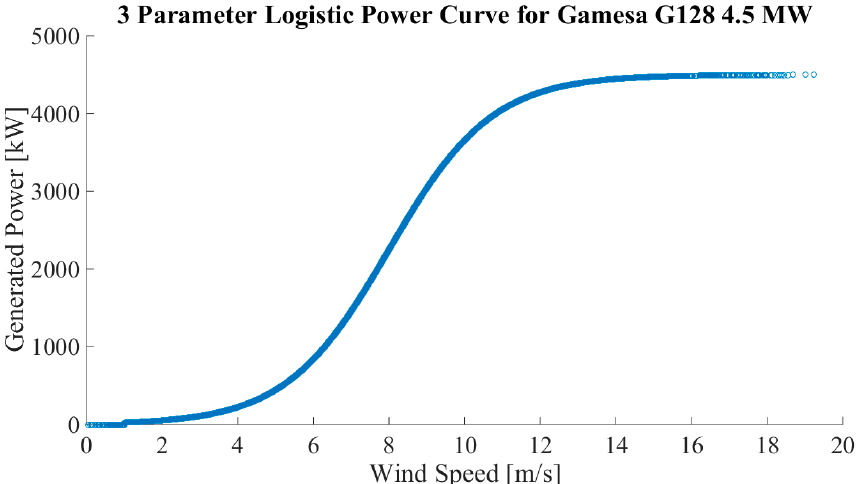
Figure 6. An example of the three-parameter logistic power curve used to transform the wind speeds to wind power. The example power curve is estimated for a Gamesa G128 4.5 MW wind turbine. The power generation shuts down at the cut-out speed, which is 27 m/s for this turbine.